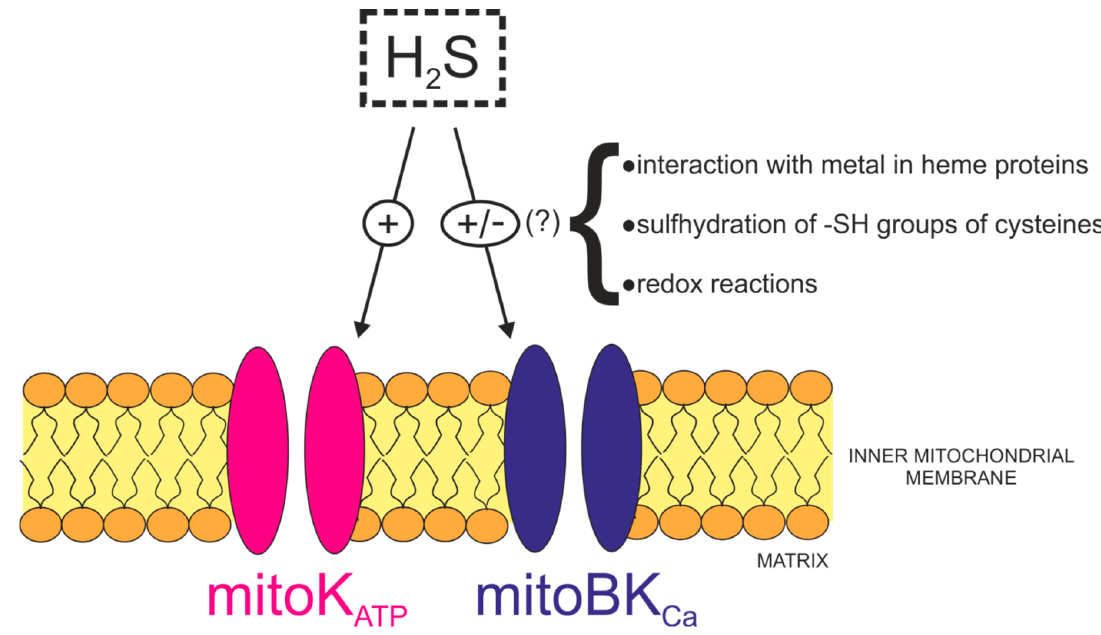
Figure 2. Regulation of mitochondrial potassium channels, mitochondrial large-conductance calcium-activated potassium channel (mitoBK Ca , activation (+) or inhibition ( − )), and ATP-sensitive potassium channel (mitoK ATP , activation (+)) by H 2 S (gasotransmitter shown in the dotted box). Modulation of the activity of the mitoBK Ca channel by H 2 S, inferred from regulation of its plasmalemmal counterpart, could result from multiple, unknown (?) mechanisms (bracket).